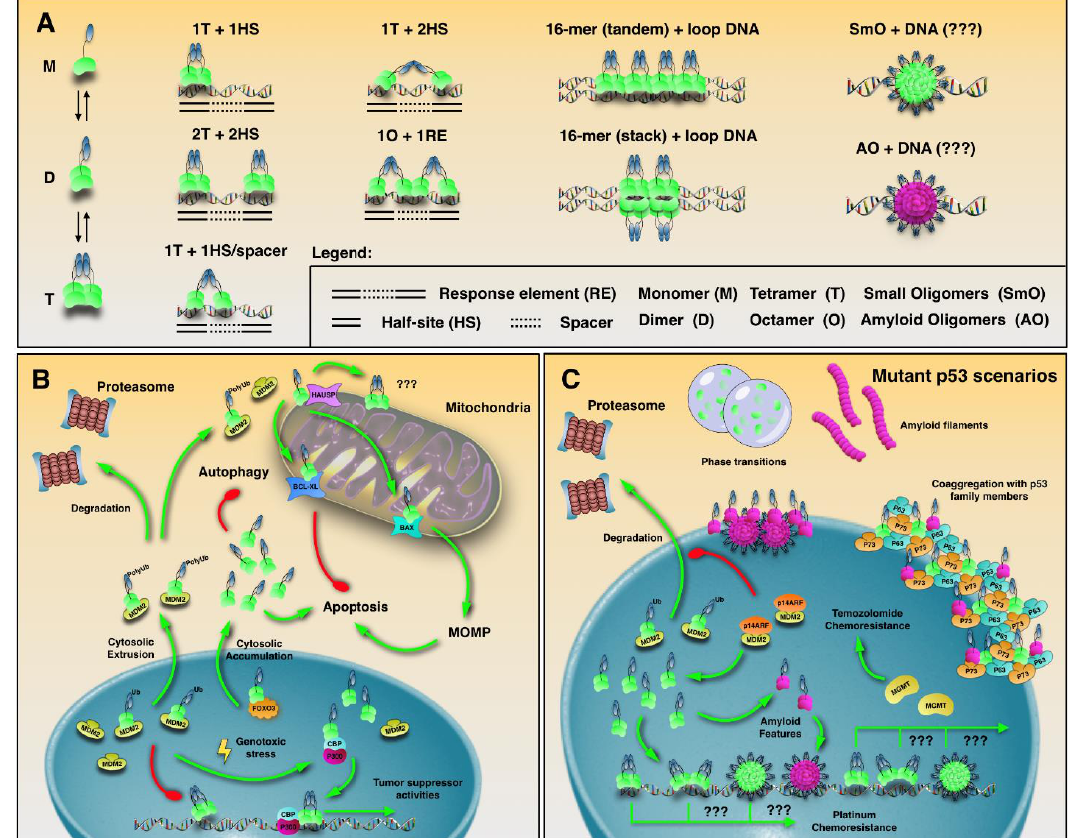
Figure 3. DNA binding and p53 signaling in the context of its oligomeric species in cancer. ( A ) Different p53–DNA interactions reported thus far. ( B ) p53 signaling emphasizing its non-transcriptional activities. ( C ) Mutant p53 signaling within the context of cancer and its aggregates. Question marks (???) show potential events not yet reported by experiments. Green and red traces show activating and inhibitory pathways, respectively.